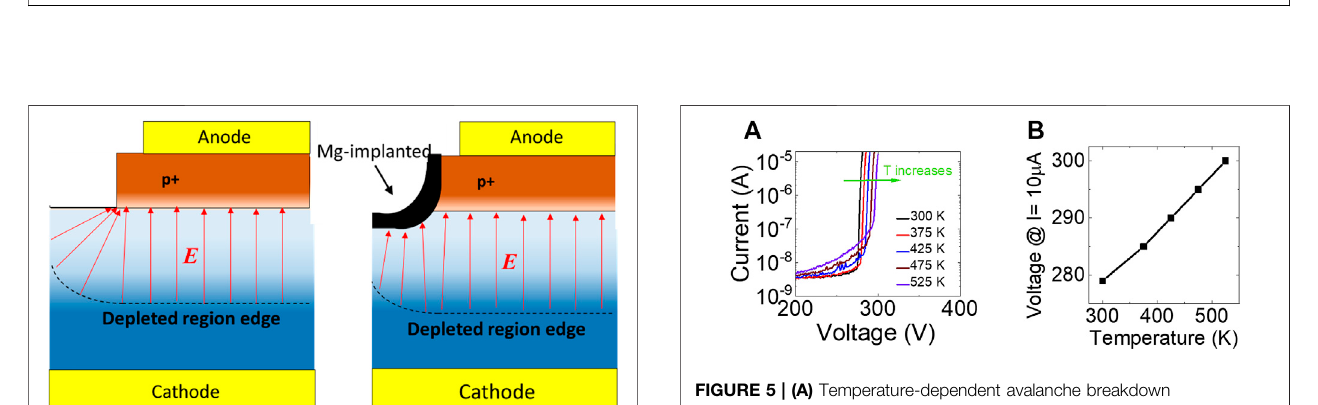
FIGURE 3 | Reported edge terminations that enable GaN pn diodes with avalanche capability: (A) ion implanted edge termination (Kizilyalli et al., 2013); (B) bevel etch edge termination (Maeda et al., 2018); (C) deep etch edge termination (Fukushima et al., 2019); (D) fi eld plate edge termination (Nomoto et al., 2016; Ohta et al., 2019); and (E) moat etch edge termination with ion implantation compensation (Ji et al., 2020a).